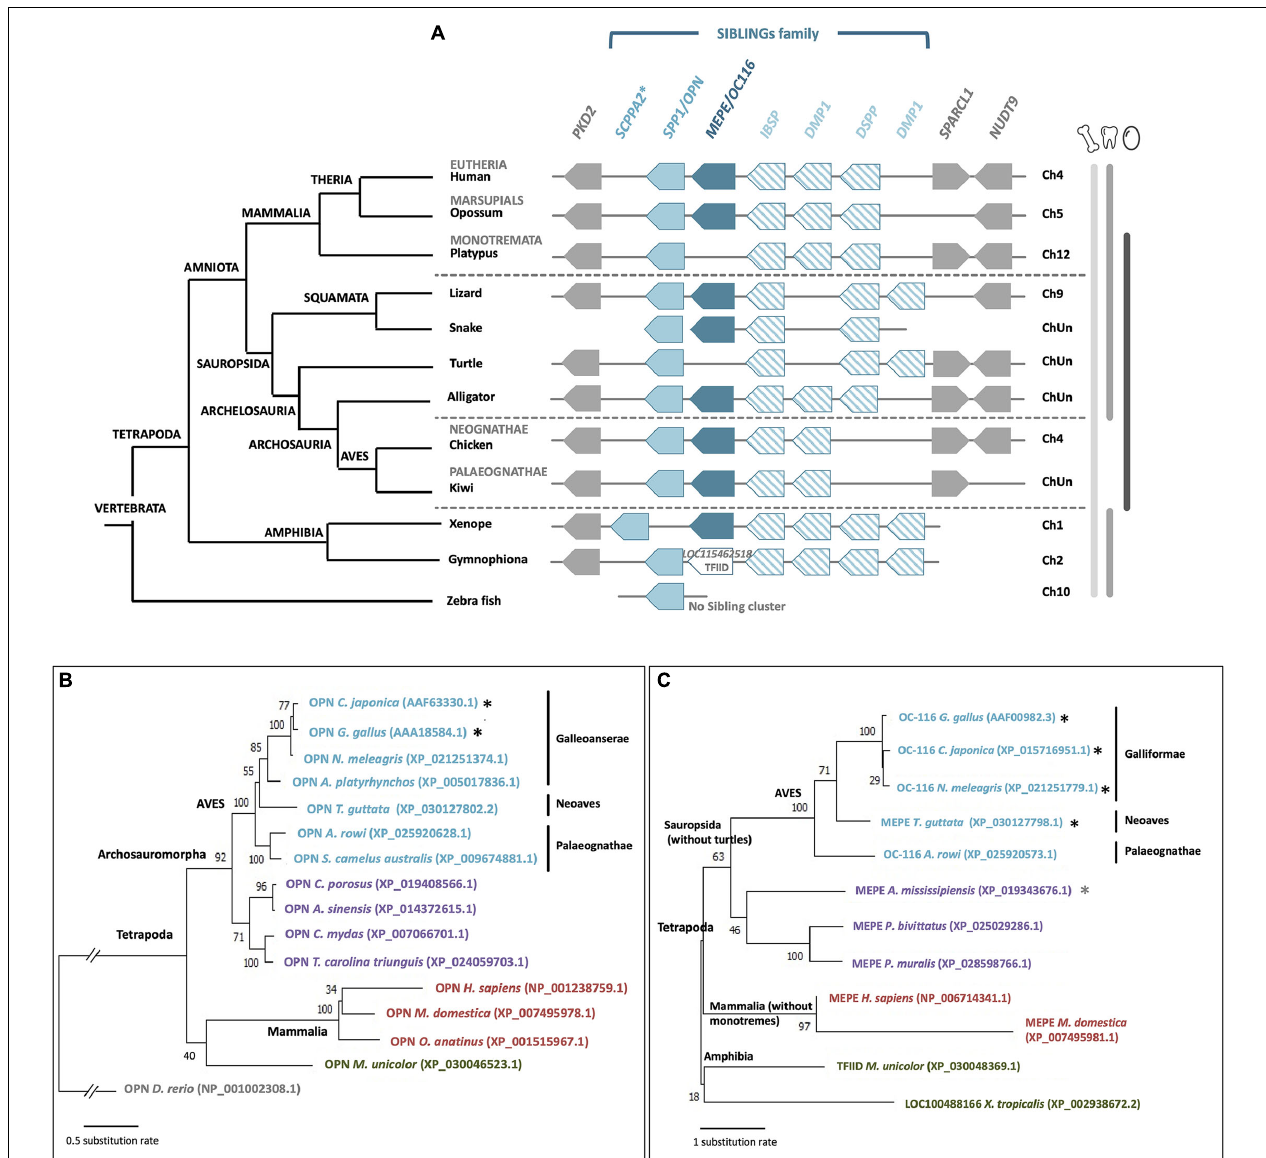
FIGURE 8 | Synteny and phylogeny of OPN/SPP1 and MEPE/OC116 genes and corresponding proteins in vertebrates. (A) OPN/SPP1 is represented by a light blue box and MEPE/OC116 is represented by a dark blue box. The other SIBLING genes are integrin-binding sialoprotein ( IBSP ), dentin sialophosphoprotein ( DSPP ) and dentin matrix protein 1 ( DMP1 ), which are represented by empty boxes with oblique blue lines. In Gymnophiona (amphibian), instead of MEPE we observed the presence of the transcription initiation factor TFIID subunit 1-like gene ( LOC115462518 , XP_030048369.1). Flanking genes are polycystin 2 ( PKD2 ), SPARC-like 1 ( SPARCL1 ) and nudix hydrolase 9 ( NUDT9 ), which are represented by gray boxes. ChUn: Chromosome Unknown. Blue asterisk indicates that SCPPA2 is a hypothetical ortholog of spp1 (Kawasaki, 2011). Gene IDs are listed in Supplementary Table 2 . In the left part, the phylogenetic tree for vertebrate species is represented (adapted from www.tolweb.org and Kapusta et al., 2017). (B) Phylogeny of OPN/SPP1 in vertebrates, which was reconstructed using multiple alignment performed with ClustalW and Gblocks (www.phylogeny.fr) and JTT + G model of protein evolution (MEGAX v10.1.8; https://www.megasoftware.net/). Topology of the tree corresponds to maximum likelihood method (MEGAX v10.1.8). Bootstrap values from maximum likelihood are indicated at each node. The symbol//indicates a gap of 0.8 substitution rate to add to the basal branch. Black asterisks indicate species where the protein was identified in the eggshell. (C) Phylogenetic reconstruction of OC-116/MEPE in vertebrates was performed using multiple alignment constructed with ClustalW and Gblocks (www.phylogeny.fr) and JTT + G + F model of protein evolution (MEGAX v10.1.8). Topology of the tree corresponds to maximum likelihood method (MEGAX v10.1.8). Bootstrap values from maximum likelihood are indicated at each node. Black asterisks indicate species where the protein was identified in the eggshell and the gray asterisk indicates a related species ( C. siamensis ) where the protein was identified in the eggshell.